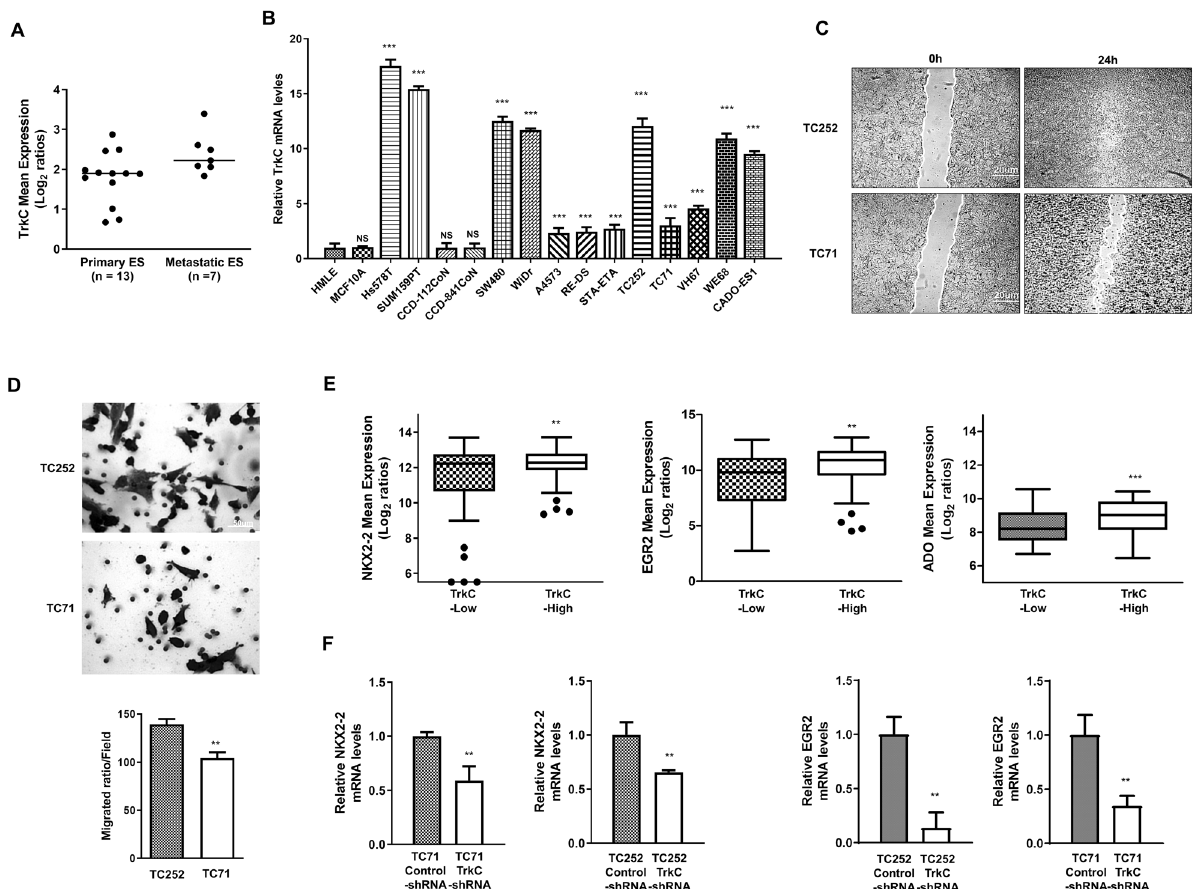
(GSE12102) and averaged for each tumor. Statistical signi fi cance was determined through t test; P value < 0.05 (**). B The expression of the mRNA encoding TrkC in ES, breast (HS578T, SUM159PT), and colorectal (SW480, WiDr) cancer cell lines relative to its normal (human mammary epithelial cell (HMLE), MCF10A, CCD-112CoN, CCD-841 CoN cell), as determined by quantitative RT-PCR. The 18 S was used for loading control. n = 3. P values < 0.001 (***); t test. NS: Not signi fi cant. C Wound-healing assay of TC252 and TC71 ES cells. Wound closures were photographed at 0 and 18 h after wounding. n = 3. D The transwell assay of in TC252 and TC71 ES cells. Migrated cells were photographed after analysis. n = 3. P values < 0.05 (**); t test. E Box-and-whisker (Tukey) plots are shown for the expression of NKX2.2, EGR2, and ADO in 117